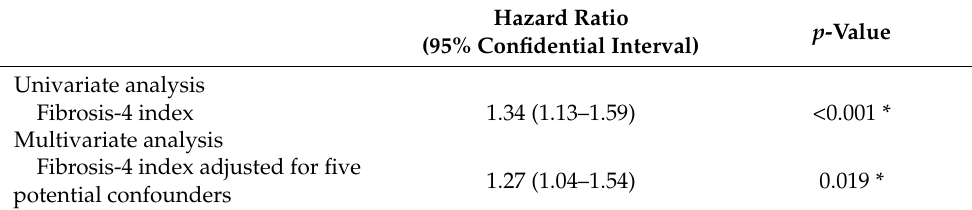
Table 3. Impact of the baseline fibrosis-4 index on the primary